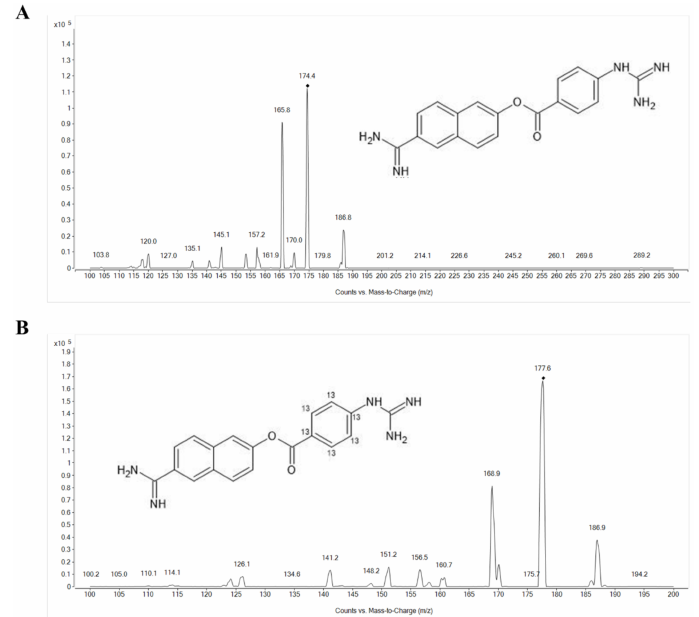
Figure 1. Product ion spectra of ( A ) protonated nafamostat ([M + 2H] 2+ , m / z = 174.4) and ( B ) 13 C 6 -nafamostat (IS) ([M + 2H] 2+ , m / z =